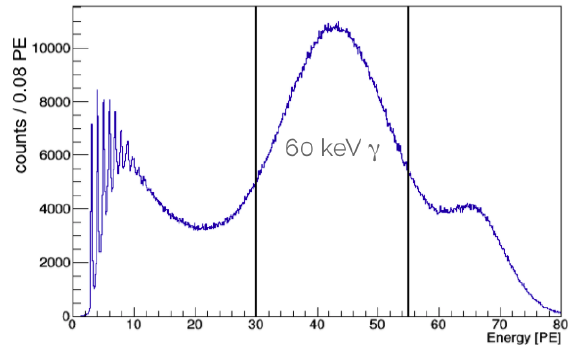
Fig. 8. After summing up the number of photo electrons (p.e.) in the three source SiPMs, the 60 keV peak is obtained. Its position contains information about the light yield in the LAr.